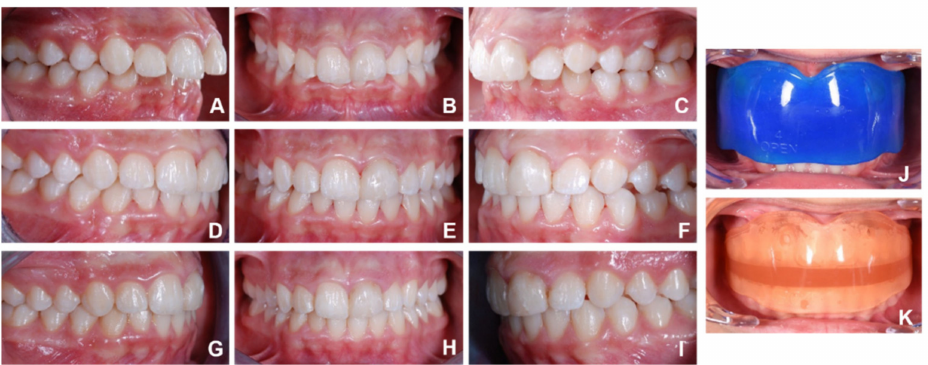
Figure 4. ( A – K )—A 10-year-old male patient (V.M.) with an augmented overjet and a deep bite. A